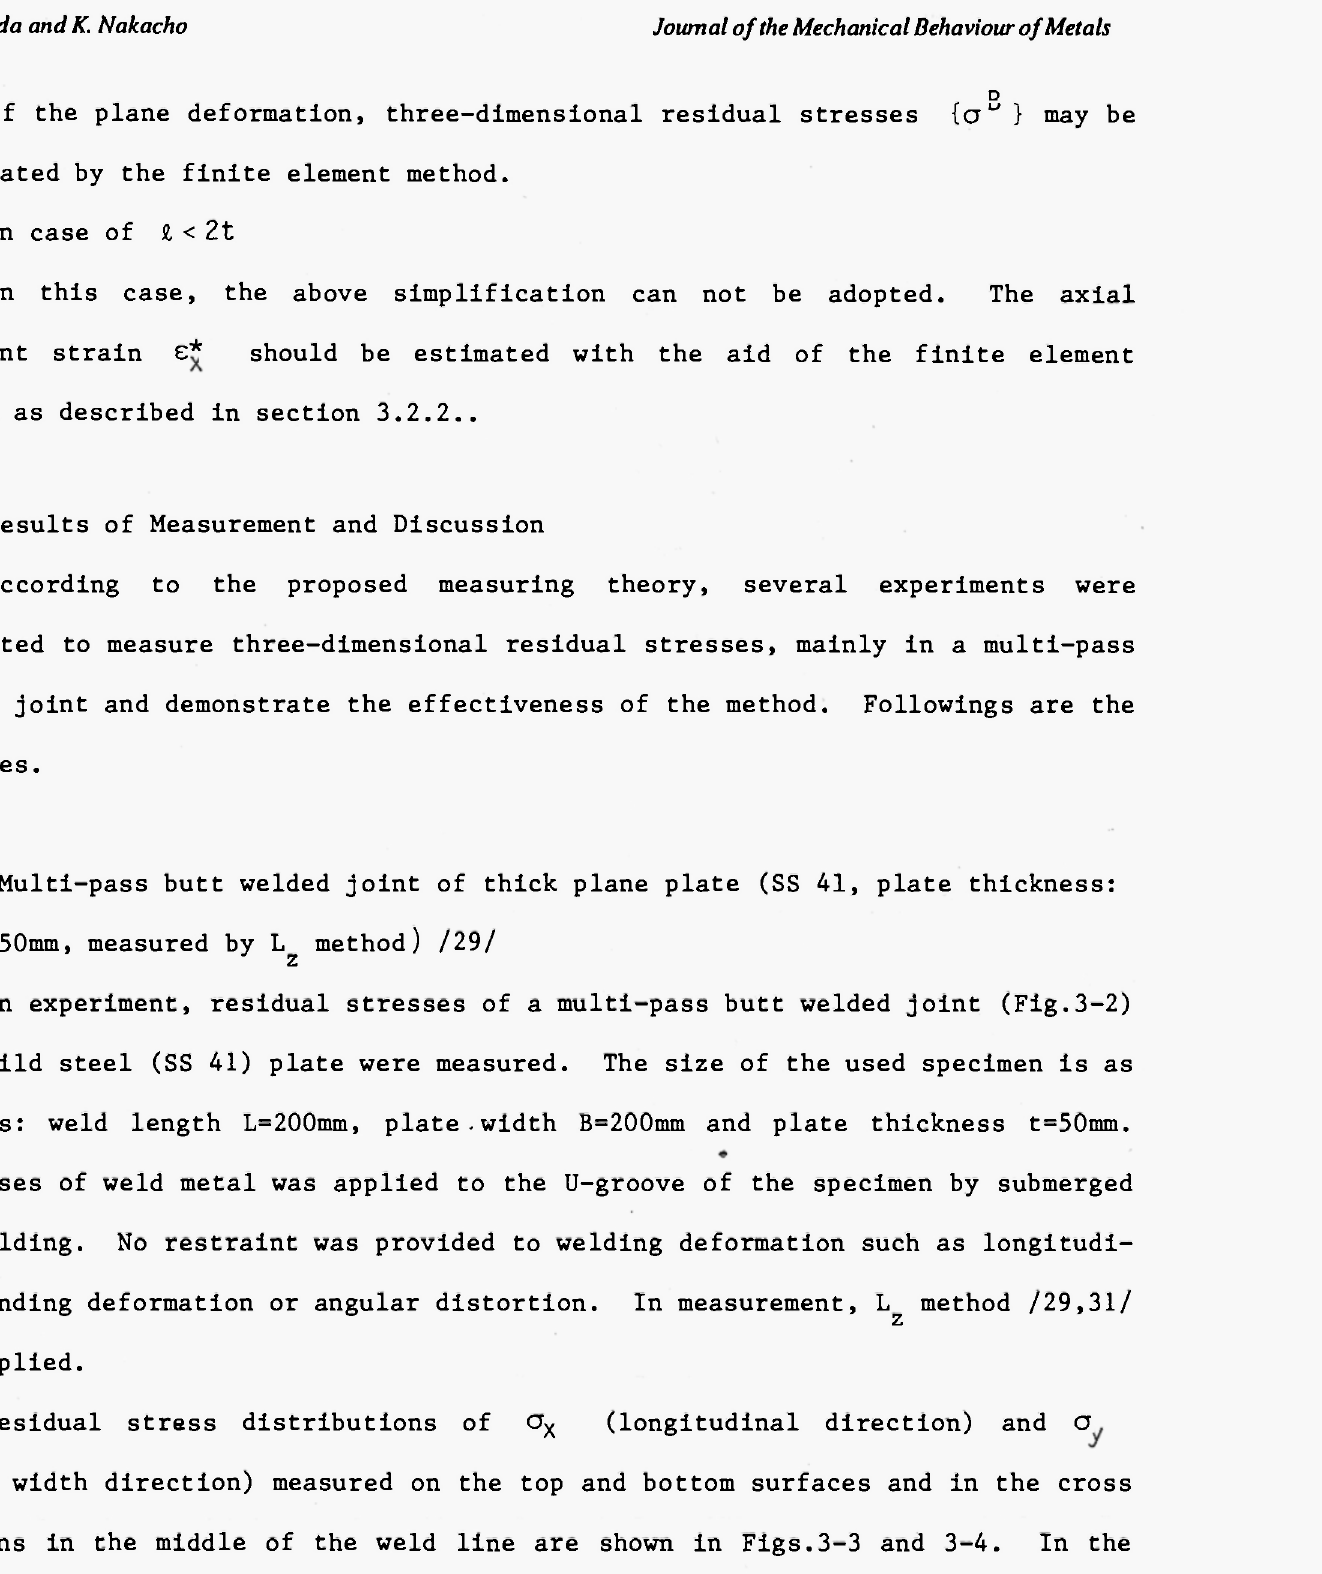
the of the stresses are indicated in order to compare with the estimated values. These directly measured